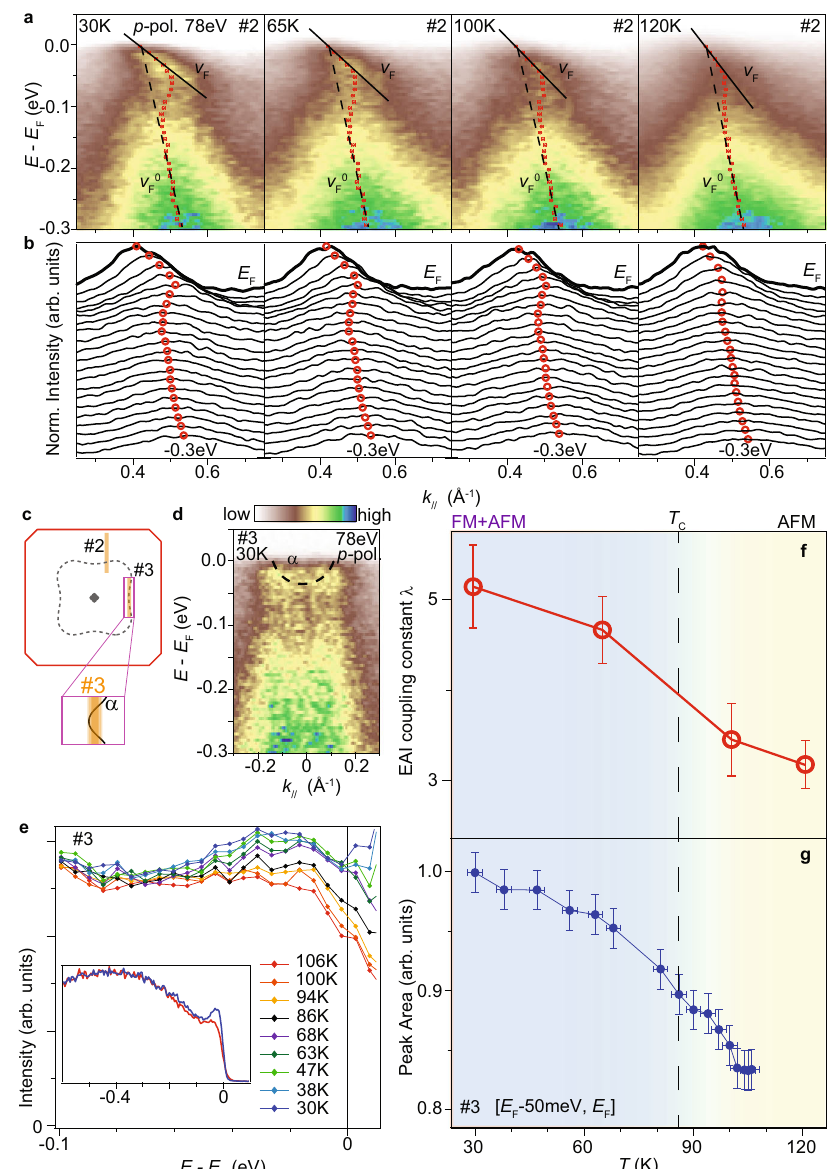
Fig. 4 | Temperature dependence of Electron – magnon interactions. a Photoemission intensity along cut #2 of Ba 0.7 K 0.3 Mn 2 As 2 at different tempera- turesmeasuredatBL4.0.3ofALS.Thesolid linesanddashedlinesillustratethethe v F and v 0 F , respectively. A momentum-independent background is subtracted. b NormalizedMDCsofspectrainpanels a .Theredcirclesinpanels a and b indicate the band dispersion from fi tting the MDCs. c Sketch of the Fermi surfaces and photoemission cuts. d Photoemission intensity along cut #3 measured at I05 of